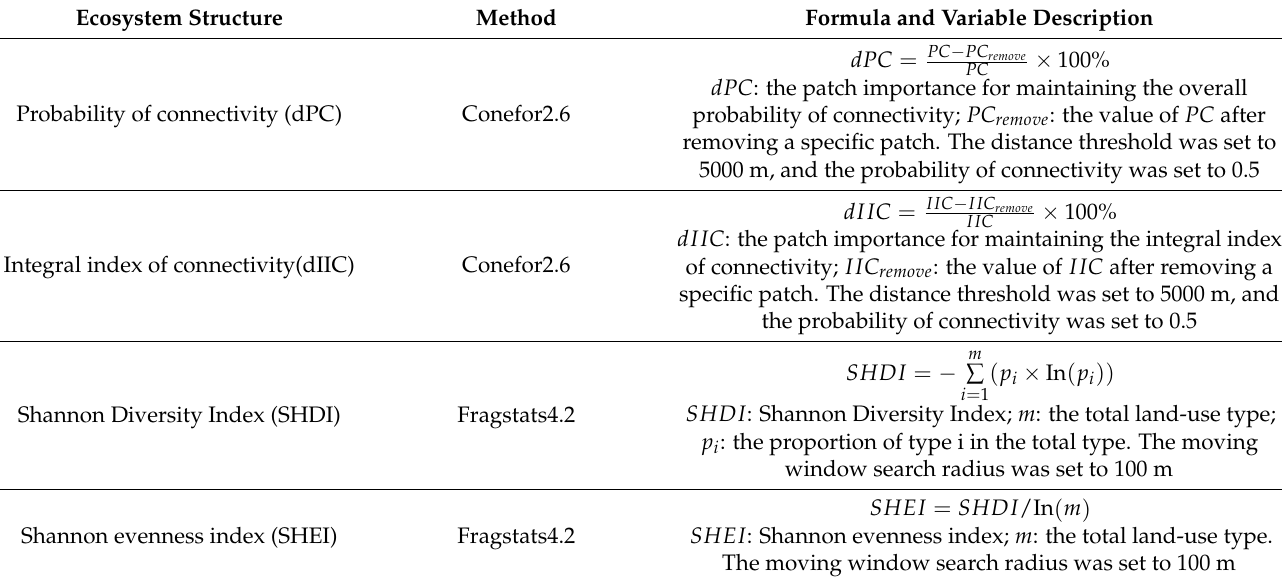
Table 2. Methods and calculation processes for ecosystem